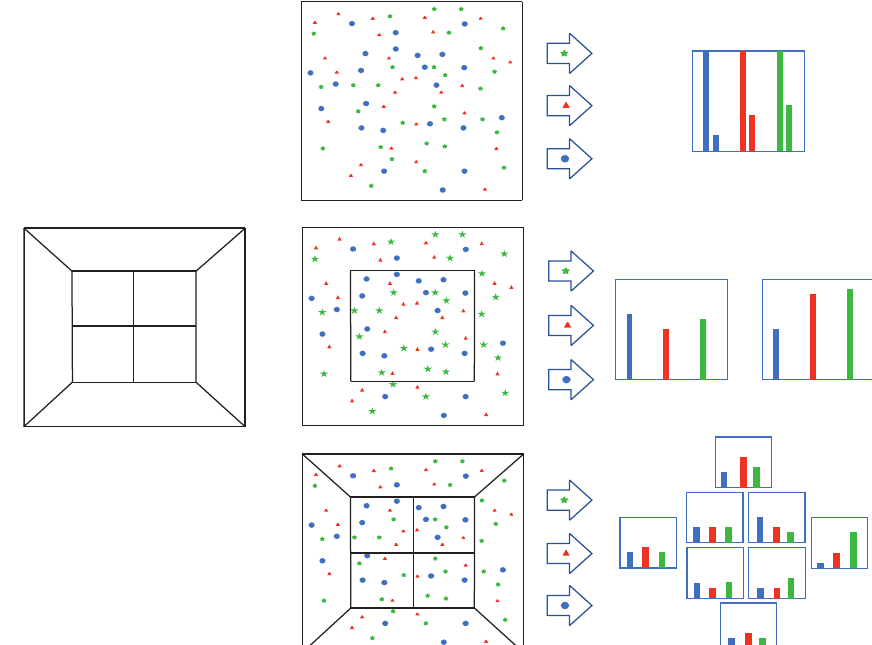
Figure 6: Schematic diagram of diagonal concentric rectangular pattern.